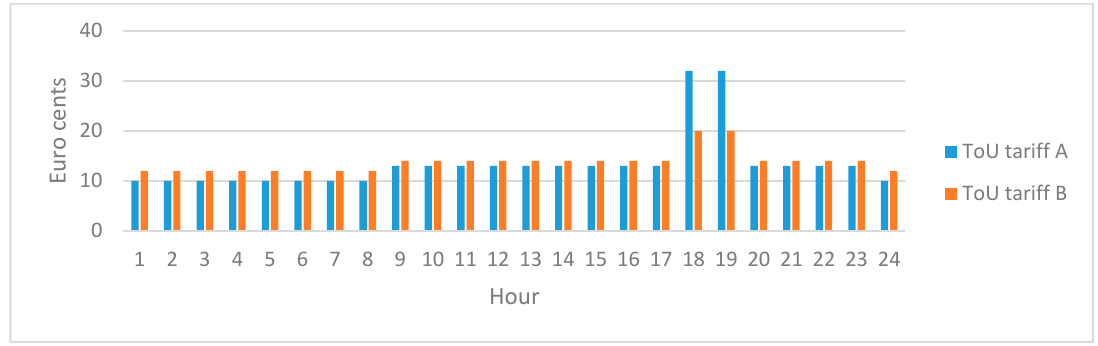
Figure 11. Time-of-use tariffs.